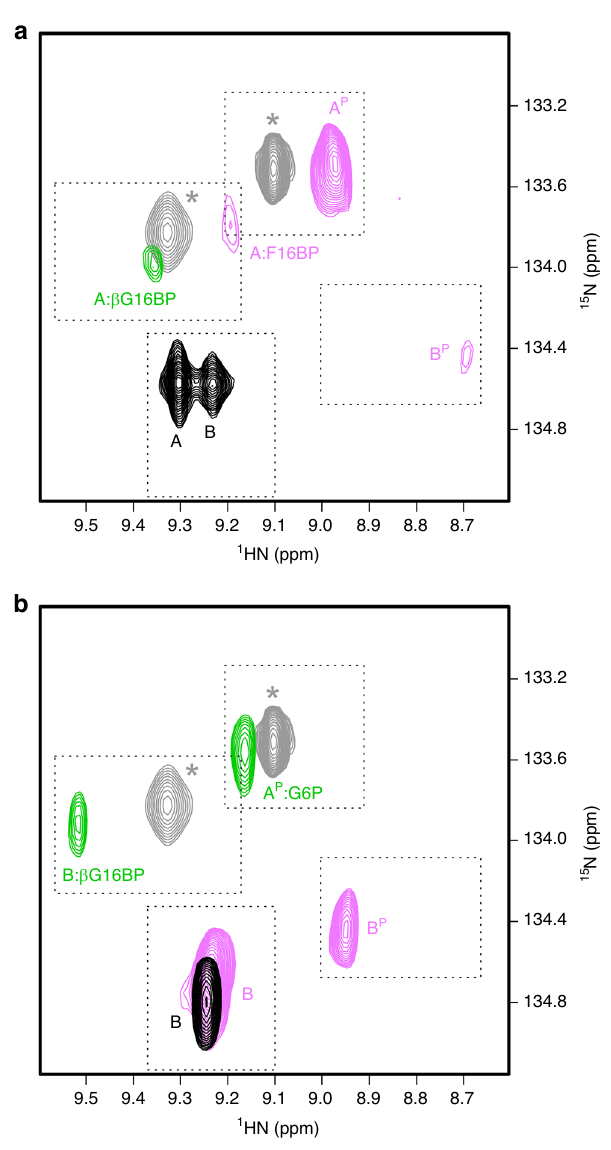
Fig. 2 Effect of different phosphorylating agents on β PGM. a , b Overlays of a section of 1 H 15 N-TROSY spectra highlighting the behaviour of residue A113. a β PGM WT (black) populates conformer A and conformer B in slow exchange. β PGM WT supplemented with F16BP (pink) populates phosphorylated conformer A (A P ) as the dominant species,